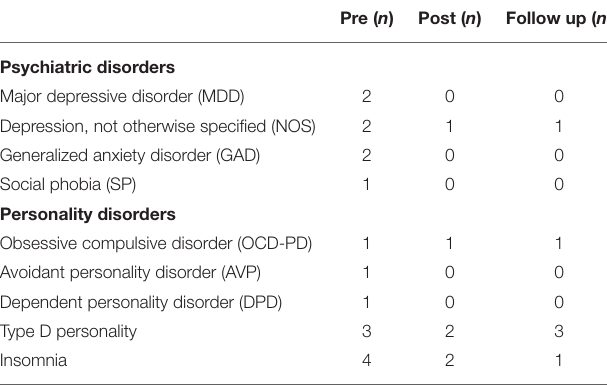
Pre ( n ) Post ( n ) Follow up ( n